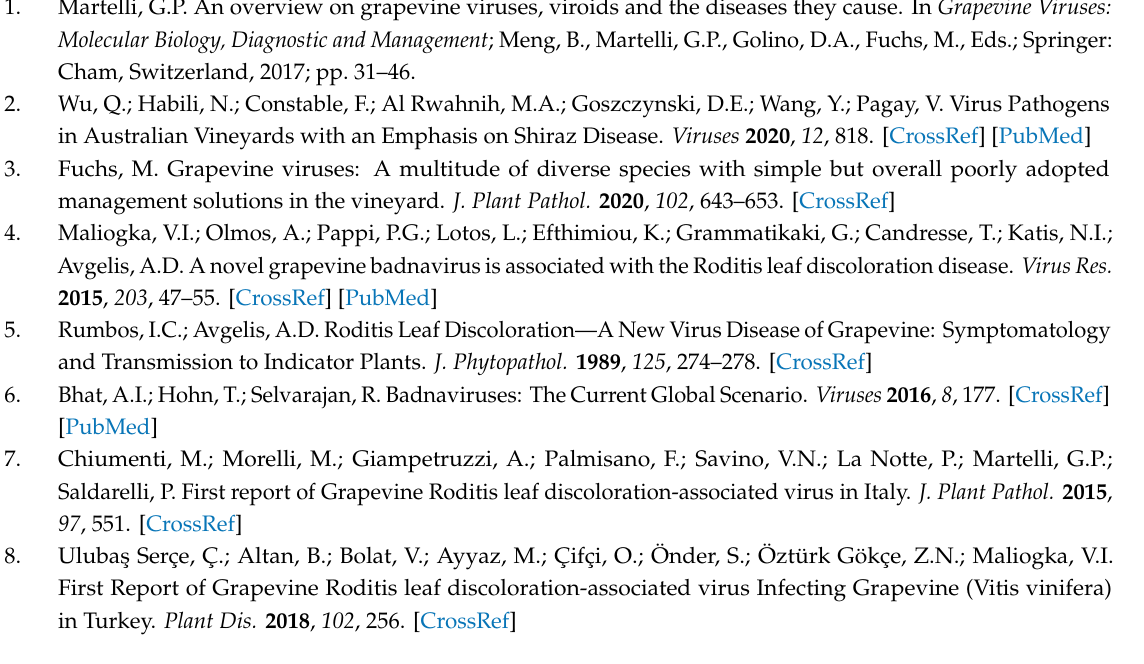
Table S1: GRLDaV titer in both pools and single mealybugs quantified by the real-time qPCR (species P. citri and P. viburni